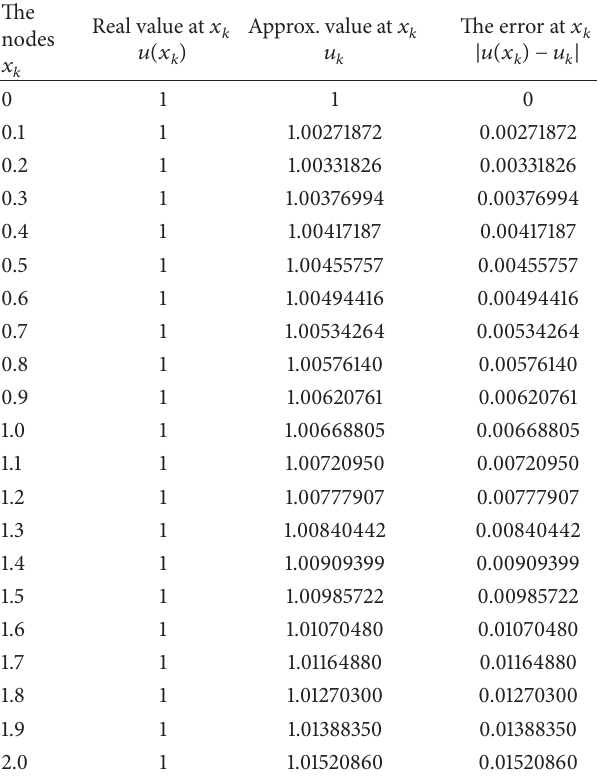
Table 1: The values of approximate solution, analytical solution, and the error at the